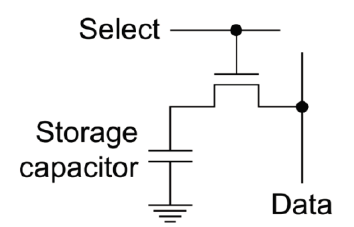
Figure 1. DRAM cells